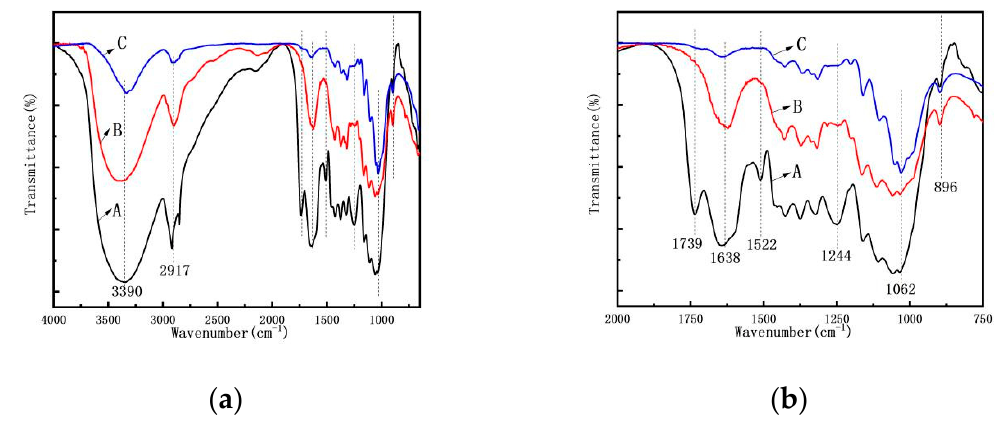
Figure 6. The FTIR spectra ( a ) of (A) Artemisia vulgaris bast powder; (B) Artemisia vulgaris bast microcellulose fiber, and (C) Artemisia vulgaris bast nanocellulose fiber. ( b ) A clearer view of peak changes in the 750–2000 cm − 1 range.